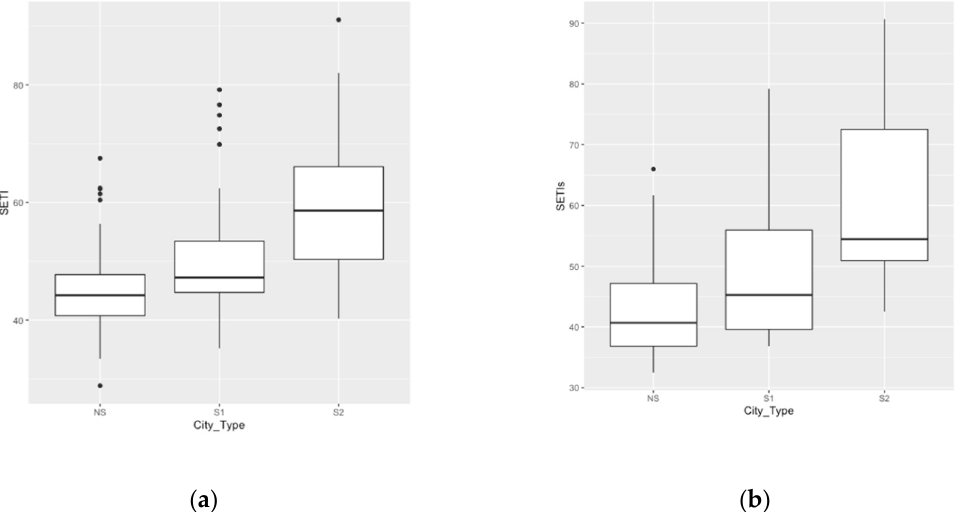
Figure 4. Boxplot and distribution of adjusted Smart Energy Transition Index (SETI) scores. ( a ) Original SETI score; ( b ) Adjusted SETI score. Table 11. Descriptive analysis of adjusted Smart Energy Transition Index scores.